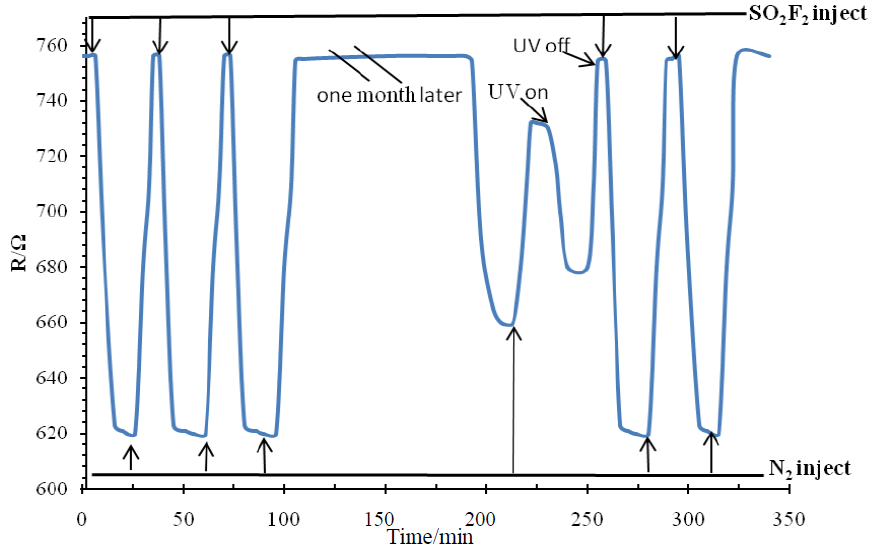
NTs sensor to SO 2